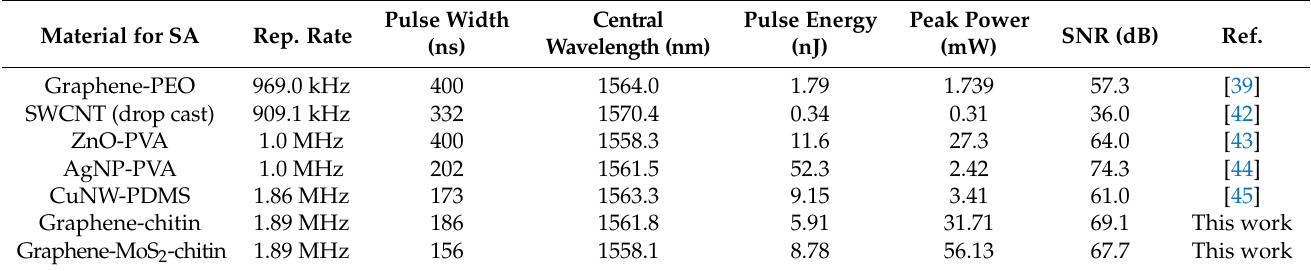
Table 1. Summary for nanosecond pulse laser generation parameters of different materials.